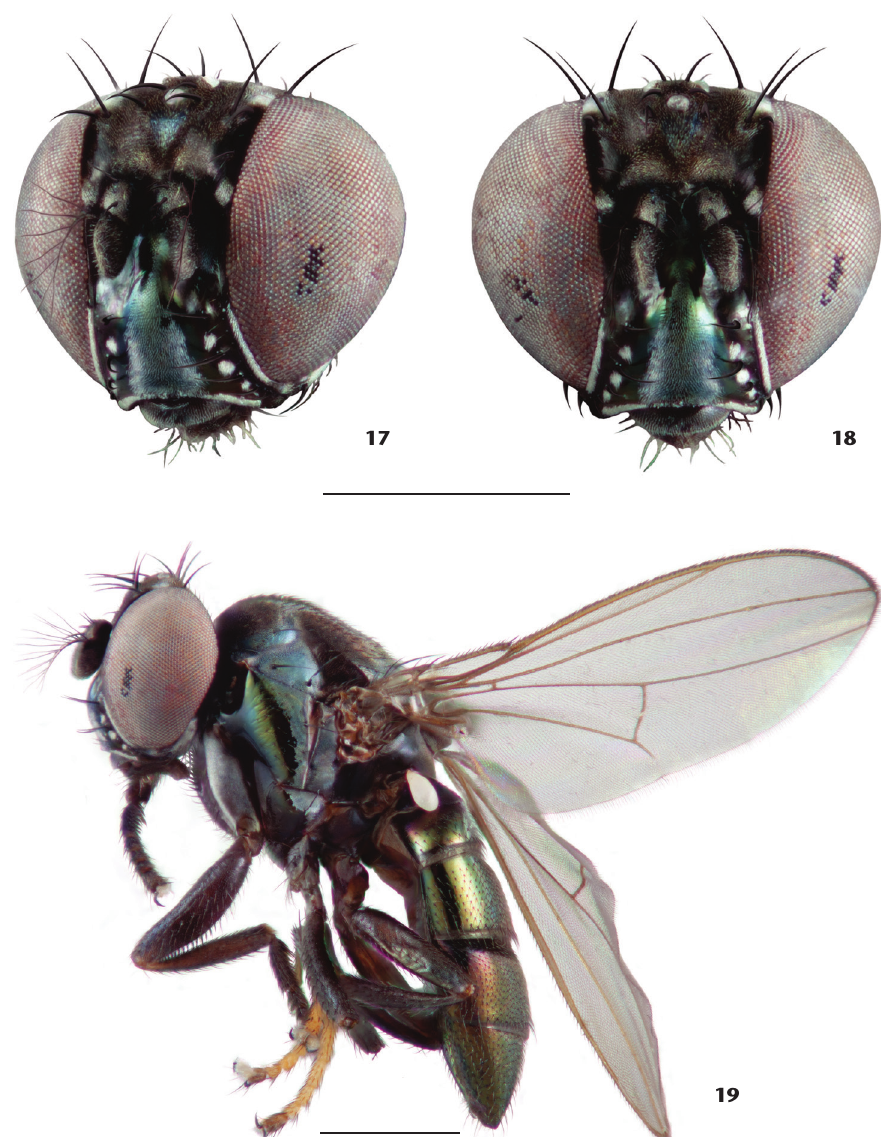
Figures 17-19. Photos of Pectinifer aeneus , male (Brazil. Paraná: Antonina): (17) head, anterolateral oblique view; (18) same, anterior view; (19) habitus, lateral view. Scale bar = 0.5